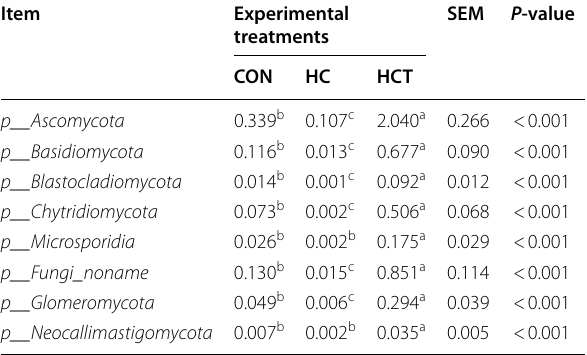
Table 3 Effect of high-concentrate diet feeding and thiamine supplementation on relative abundances of fungi phylum in rumen fluid